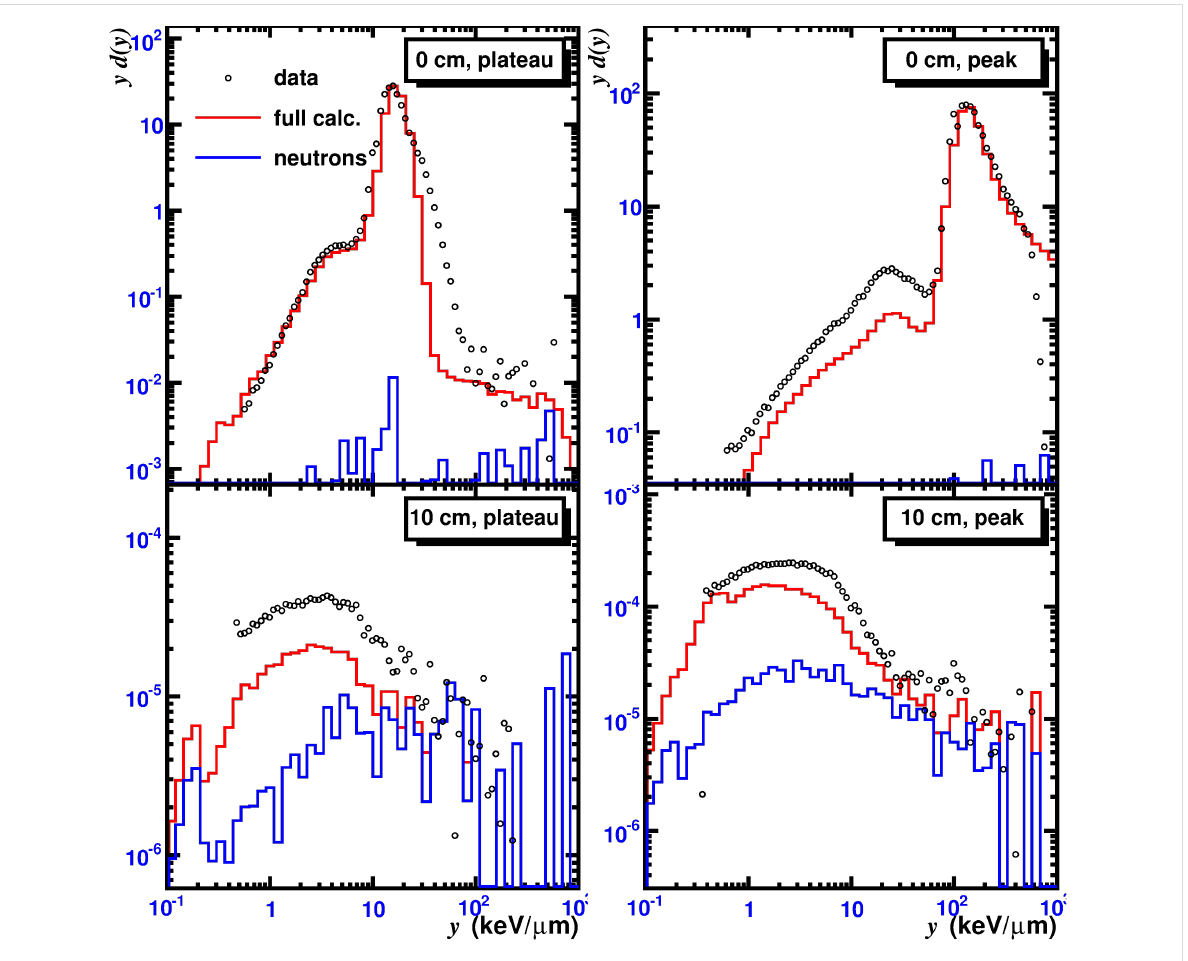
Figure 5: Microdosimetric spectra in a water phantom irradiated by 300 A MeV 12 C nuclei. Upper (red) histograms are the total spectra calculated with MCHIT, the lower (blue) histograms show the neutron contributions. Data points from [6].